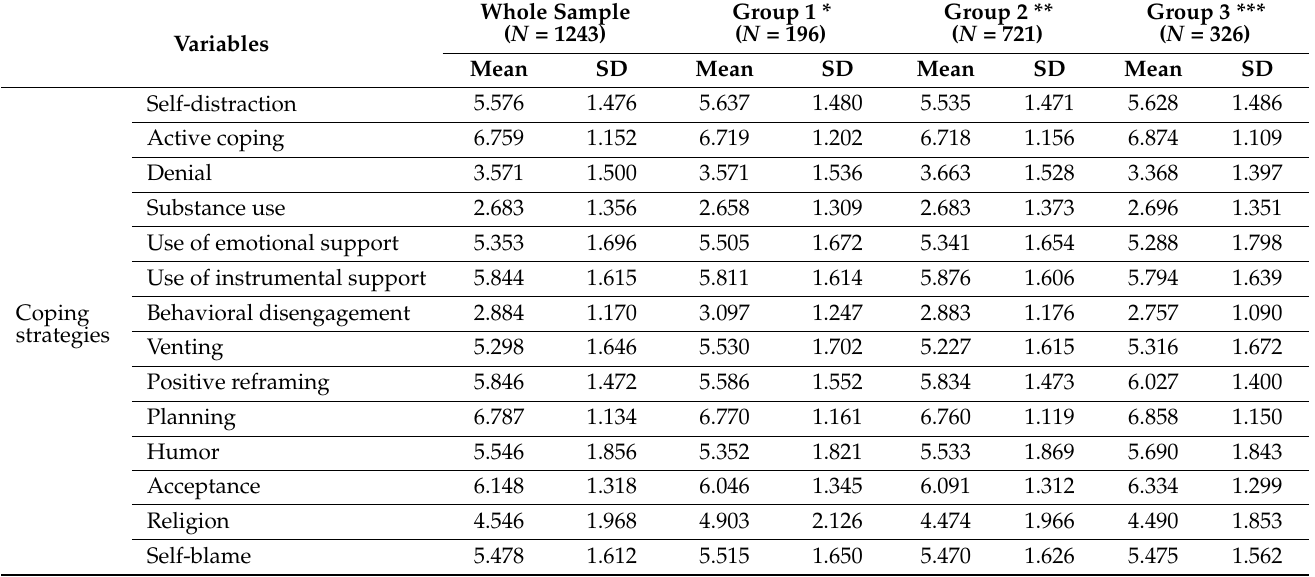
Table 2. HPV knowledge and psychological